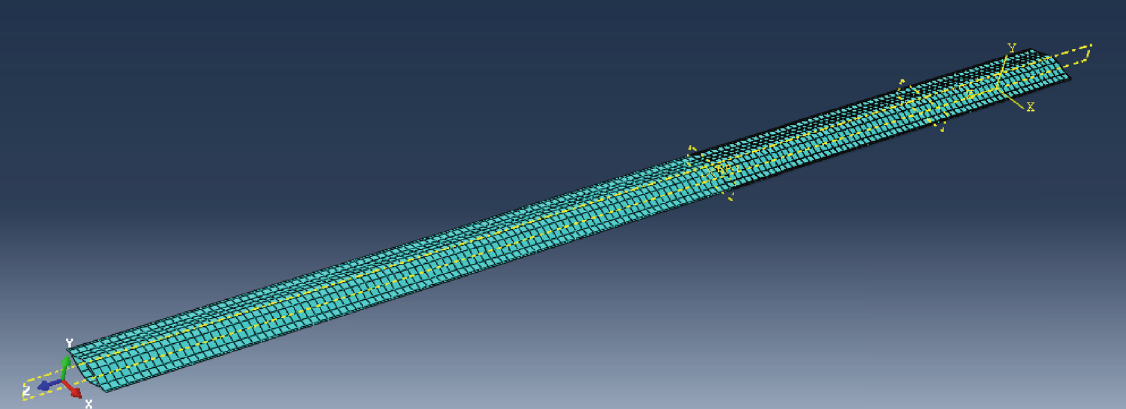
Figure 8: FEA model of the lenticular booms.